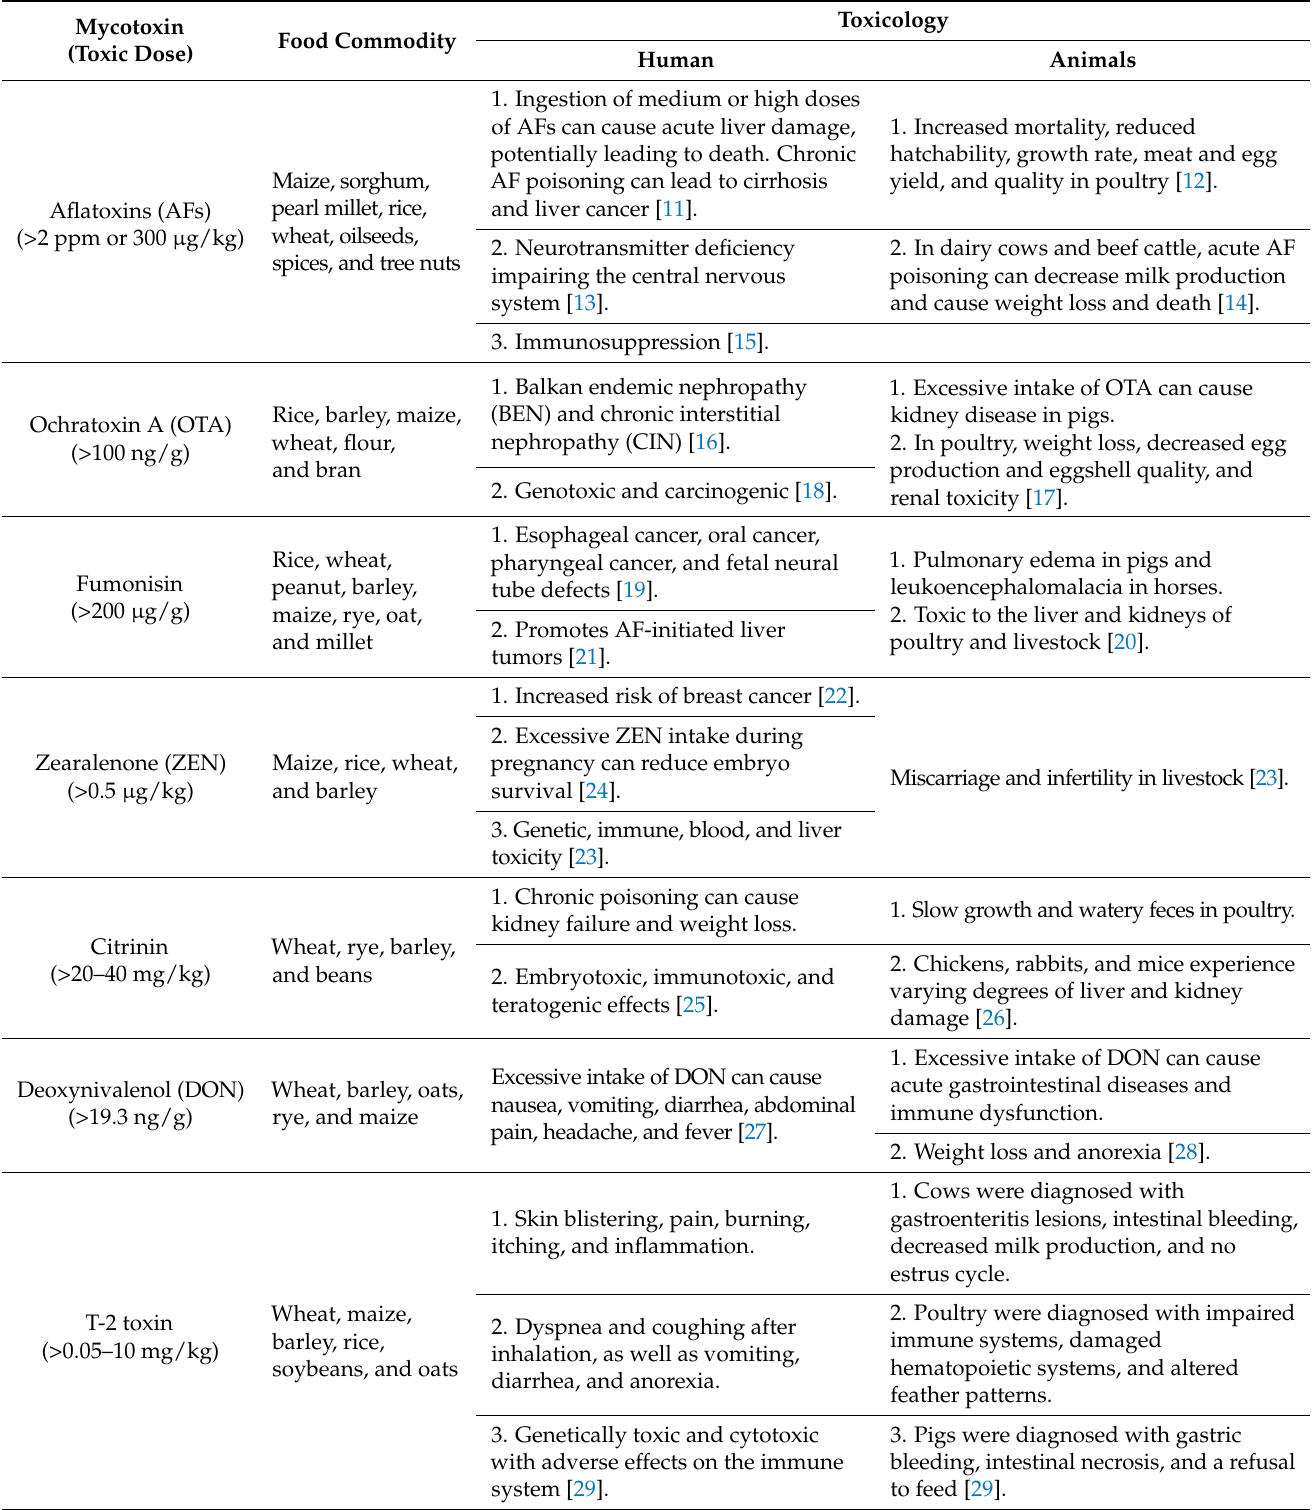
Table 1. Common mycotoxins in cereals and their